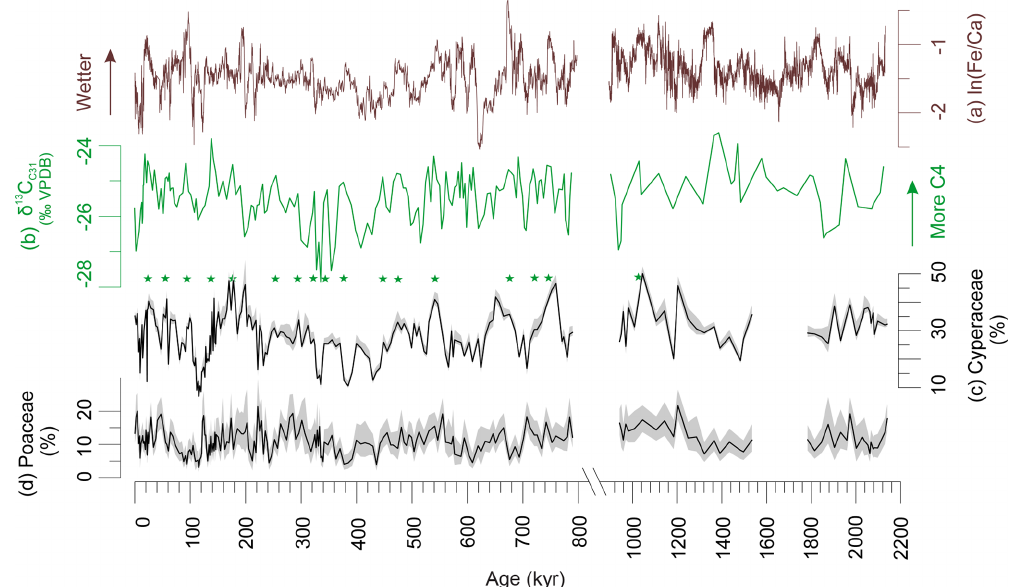
Figure 2. Indicators of C 4 vegetation and terrestrial input. (a) Elemental Fe / Ca ratios (Caley et al., 2018c); less negative values indicate relatively wetter conditions. (b) δ 13 C wax of the n -alkane C 31 (Castañeda et al., 2016b; Caley et al., 2018e); less negative values of around − 24‰ indicate more C − 28‰ indicate more C 4 inputs while more negative values of around 3 inputs. (c) Cyperaceae (sedges) pollen percentages (Dupont et al., 2011b, this study). (d) Poaceae (grass) pollen percentages (Dupont et al., 2011b, this study). Shaded areas denote 95% confidence intervals after Maher Jr. (1972). Stars denote corresponding maxima in Cyperaceae pollen percentages and the stable carbon isotopes indicating C 4 vegetation. VPDB: Vienna Pee Dee Belemnite. Note the scale